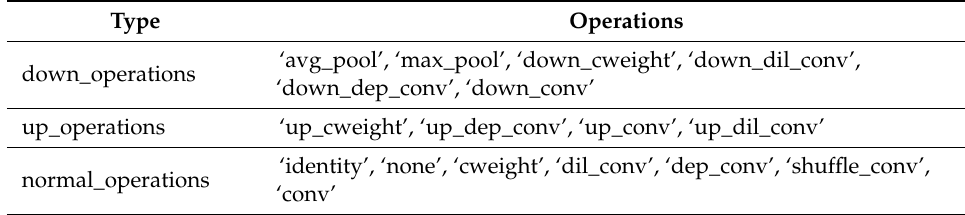
Table 3. Primitive operations by type: down, up, and normal